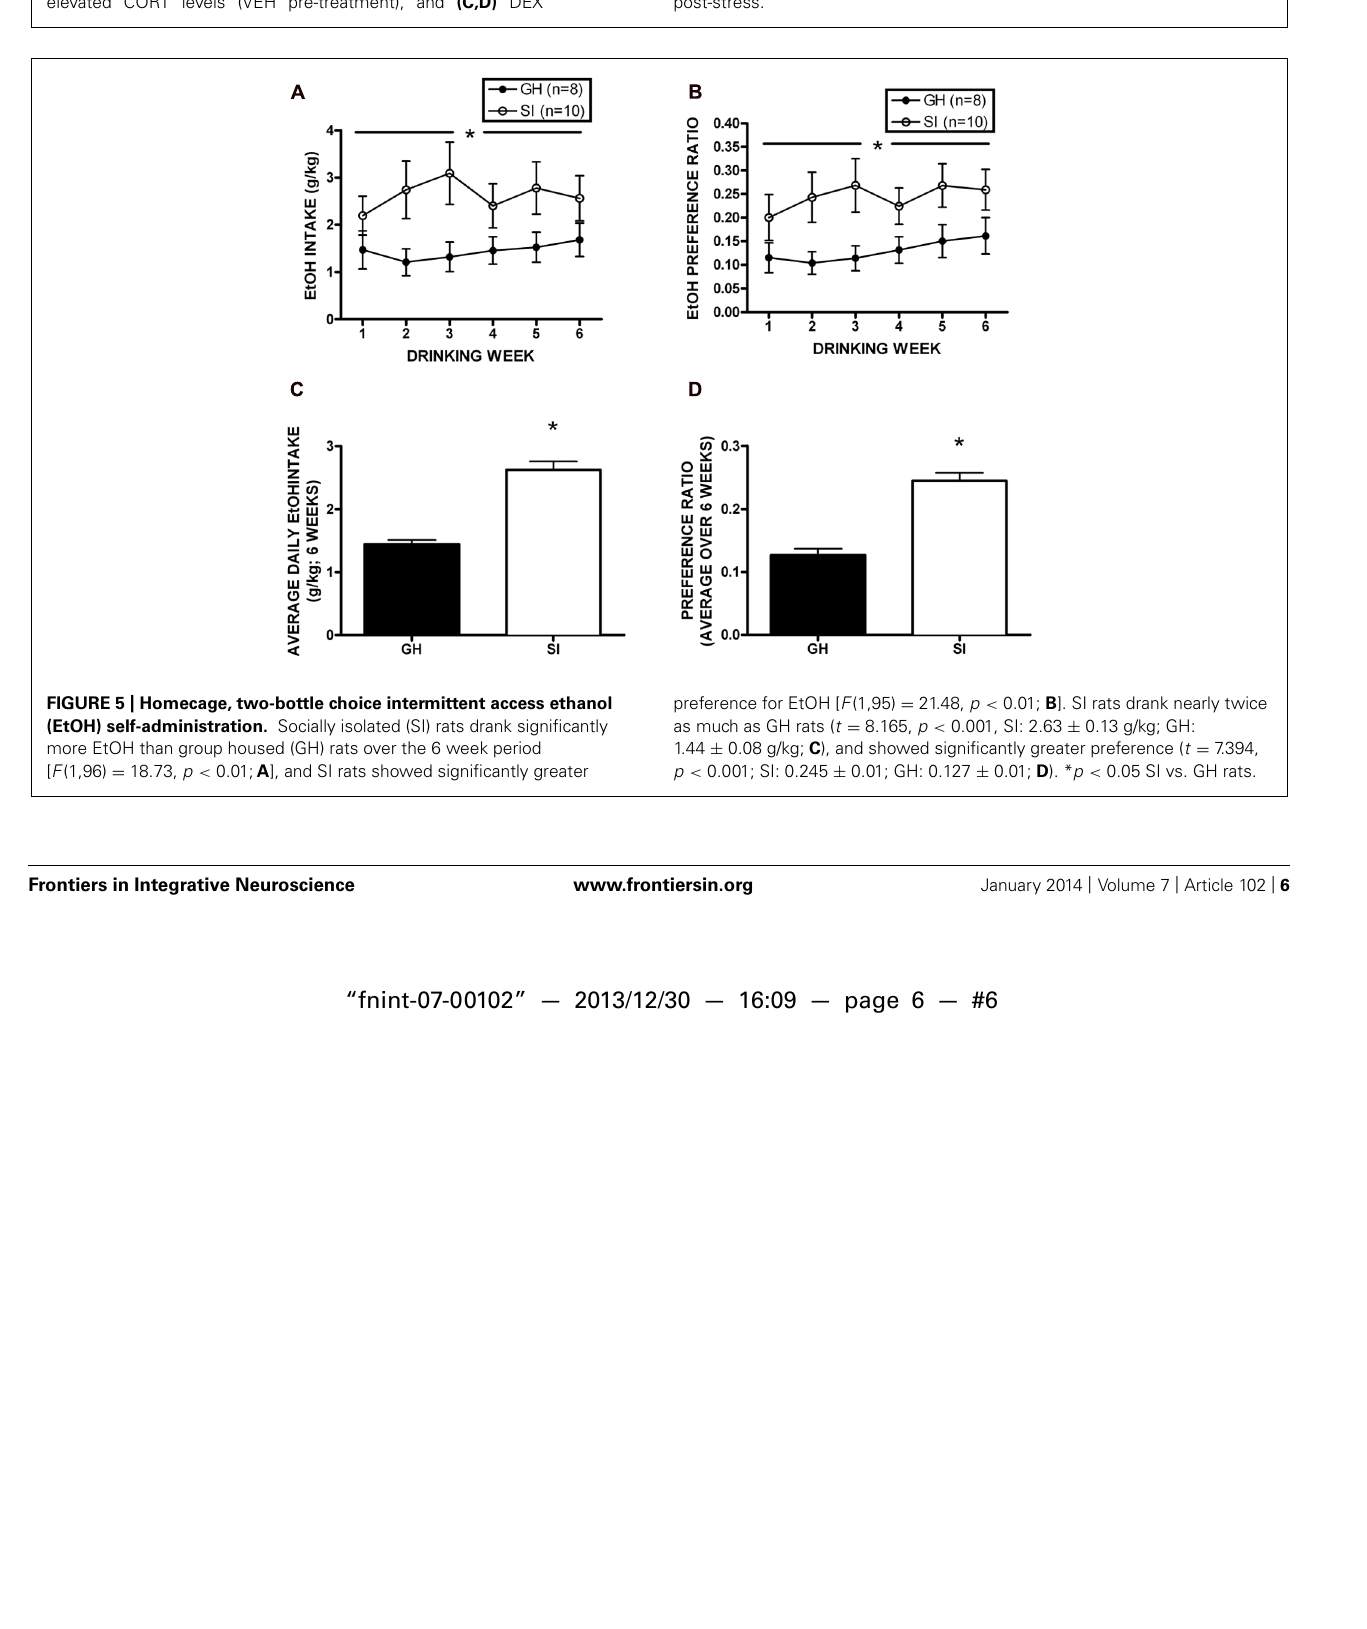
FIGURE 4 | Corticosterone (CORT) levels in response to swim stress with VEH and dexamethasone (DEX) pre-treatment. (A,B) . A main effect of treatment group indicated that stress significantly elevated CORT levels (VEH pre-treatment), and (C,D) DEX